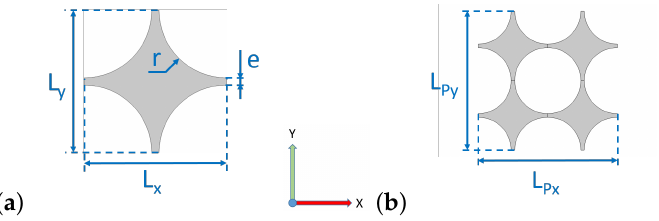
Figure 2. Reference structure S 0 : ( a ) unit cell and ( b ) periodic